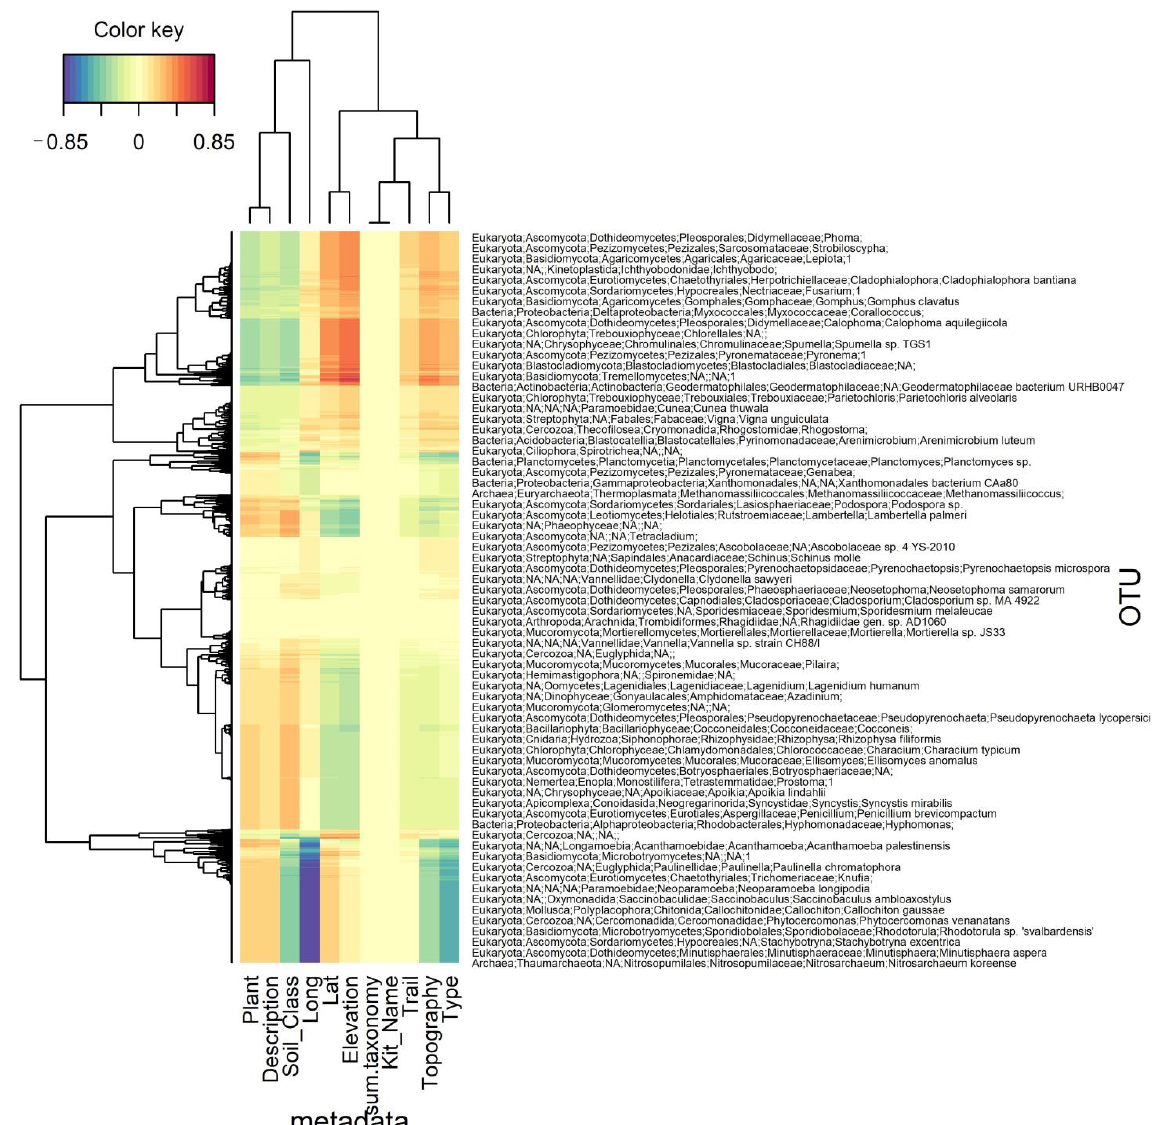
Figure 4. Clustered Image Map. There was a suite of functional traits related to wildfire resiliency that was found to be consistent across clusters of samples in the sPLS results.